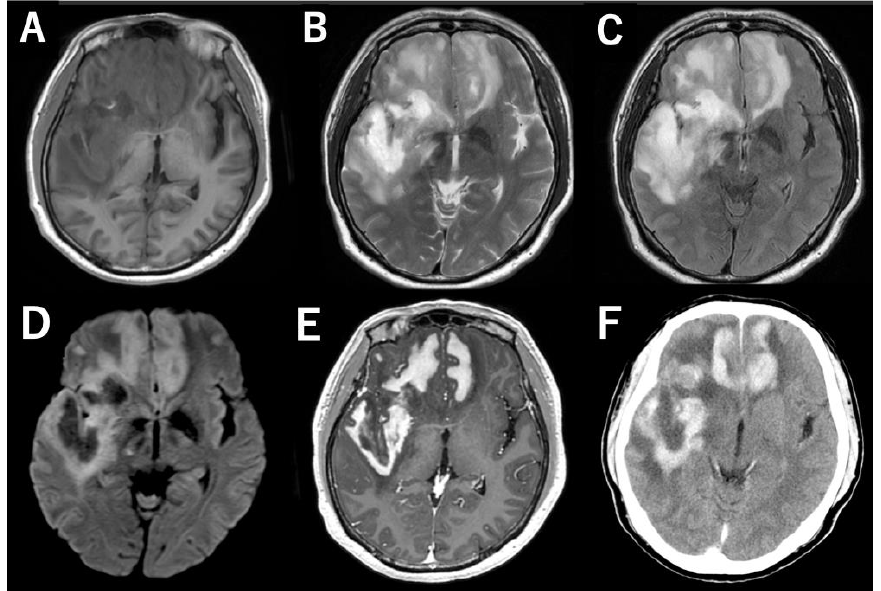
Figure 1. MR and CT images show a large homogenously enhancing lesion spanning the bilateral frontal lobes and the right temporal lobe. ( A ) T1-weighted image (T1WI), ( B ) T2WI, ( C ) FLAIR, ( D ) DWI, ( E ) post-contrast MRI, ( F ) post-contrast CT.